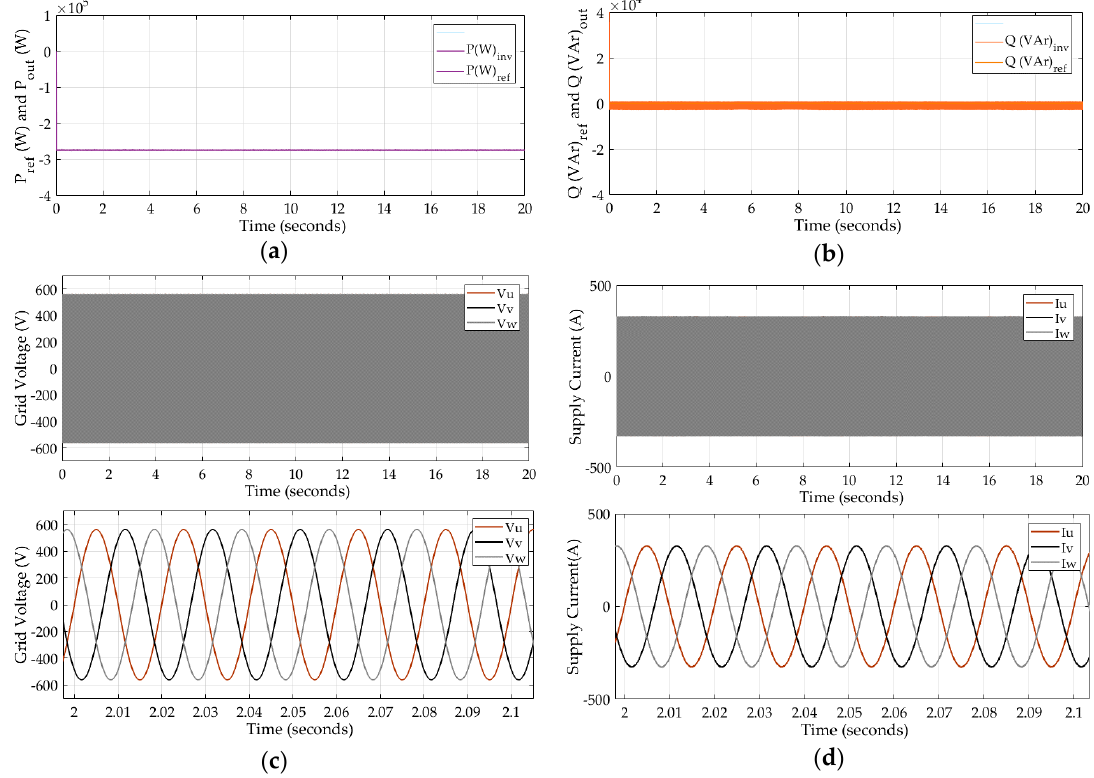
Figure 8. The FCS–MPC performance of 2L-VSI: ( a ) Active power output to the grid P (W); ( b ) Reactive power output to the grid Q (VAr); ( c ) Grid peek voltage V pk (V); ( d ) Grid peek current I pk (A).